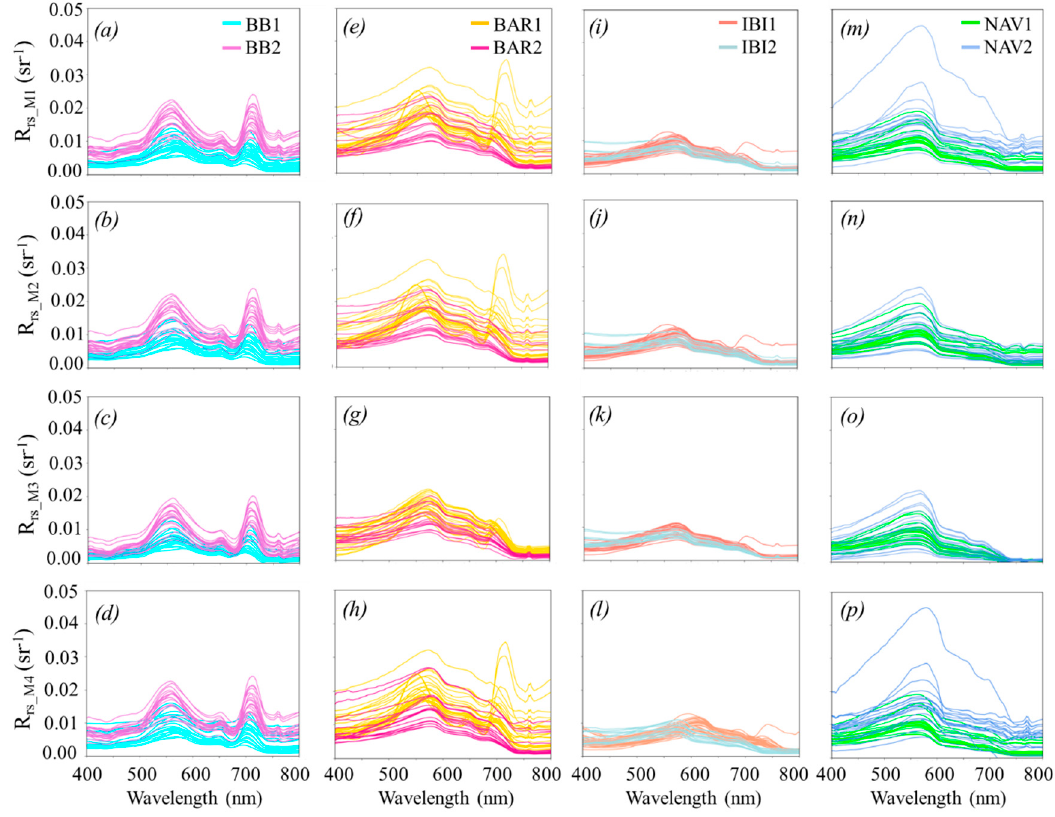
Figure 4. All sampled R rs curves calculated from M1, M2, and M3 approaches (represented by R rs_MX ) in respective fieldworks ( a – d ) BB1 and BB2 (Barra Bonita); ( e – h ) BAR1 and BAR2 (Bariri); ( i – l ) IBI1 and IBI2 (Ibitinga); and ( m – p ) NAV1 and NAV2 (Nova Avanhandava).